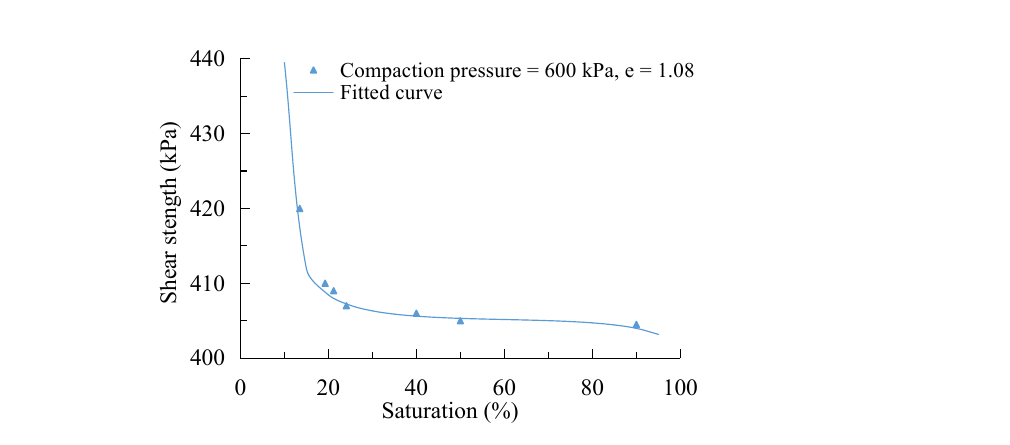
Figure 21. Calculated results on the shear strength of the compaction pressure for 600 kPa.